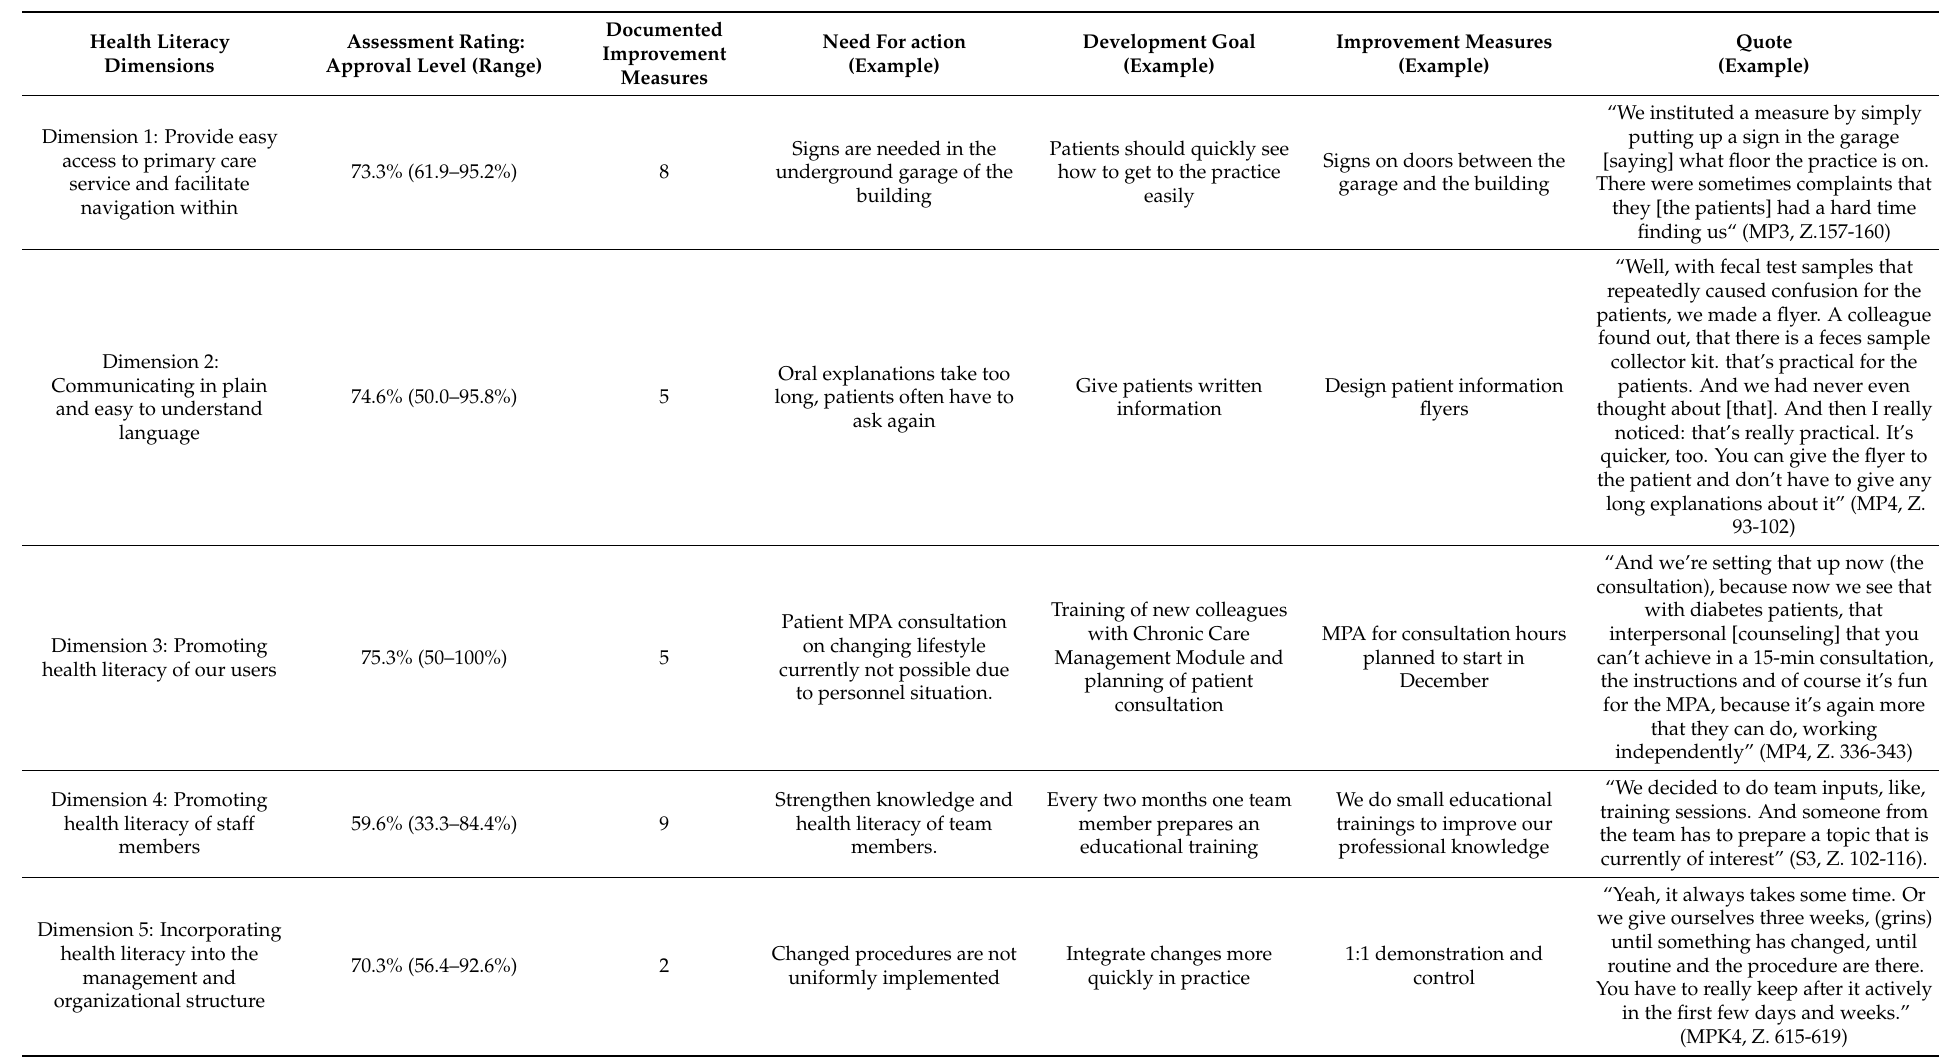
Table 4. Examples of improvement